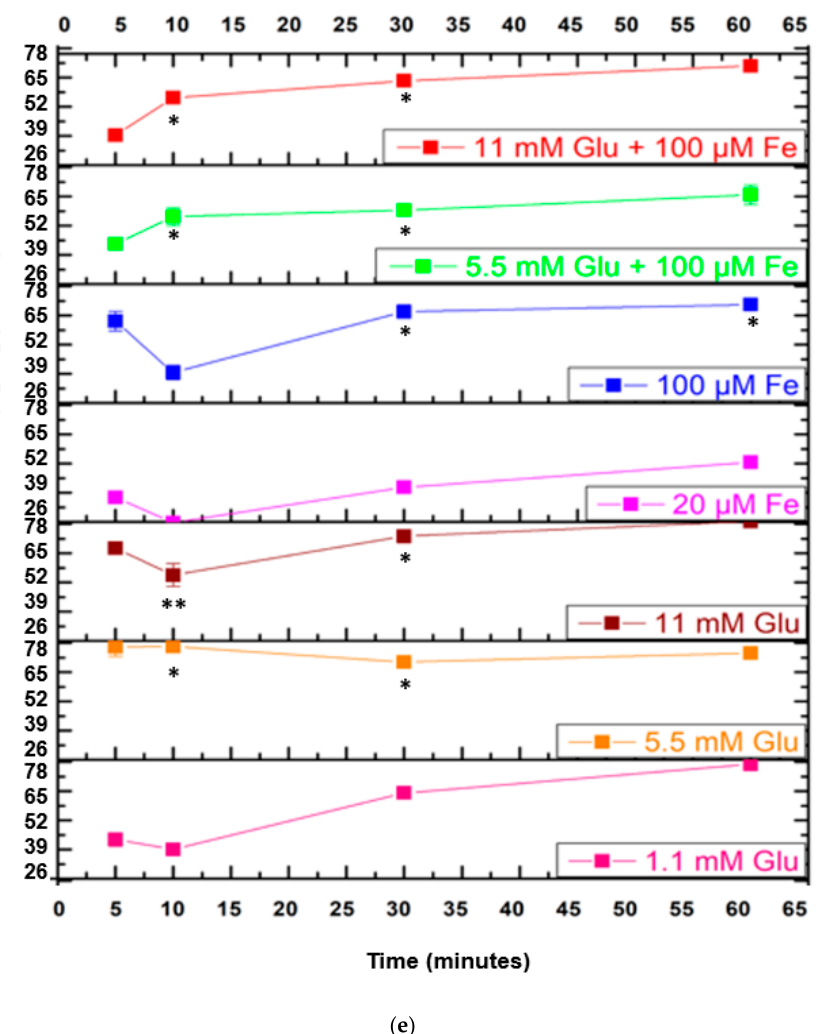
Figure 7. The effect of treatment with varying concentrations of iron, glucose, and combinations of iron and glucose with the addition of tolbutamide on MIN6 cells insulin secretion. ( a ) The effect of treatment with 5.5 mM and 11 mM of glucose with the addition of tolbutamide on MIN6 cells insulin secretion following 3 h and 24 h incubation. The data represent mean ± SEM, n = 3. ( b ) The effect of treatment with 20 µ M and 100 µ M iron with the addition of tolbutamide on MIN6 cells insulin secretion following 3 h and 24 h incubation. The data represent mean ± SEM, n = 3. ( c ) The effect of treatment with 5.5 mM and 11 mM of glucose and/or 20 µ M and 100 µ M iron and combinations of iron and glucose with the addition of tolbutamide on MIN6 cells insulin secretion following 3 h and 24 h incubation. The data represent mean ± SEM, n = 3. ( d ) The effect of treatment incubation with varying concentrations of iron, glucose, and combinations of iron and glucose with the addition of tolbutamide on MIN6 cells insulin secretion acutely (5, 10, 30, 60 min). The data represent mean ± SEM, n = 3. * p < 0.0036 (5.5 mM Glu (C1)—10 min), ** p < 0.037 (11 mM Glu (C2)—10 min), ** p < 0.005 (20 µ M Fe (C3)—10 min), * p < 0.026 (5.5 mM Glu + 20 µ M Fe (C6)—10 min), * p < 0.01 (11 mM Glu + 100 µ M Fe (C8)—10 min); * p < 0.013 (C3—60 min). ( e ) The effect of treatment with varying concentrations of iron, glucose, and combinations of iron and glucose with the addition of tolbutamide on MIN6 cells insulin secretion following 24 h (5, 10, 30, 60 min). The data represent mean ± SEM, n = 3. * p < 0.049 [11 mM Glu (C2)—24 h (5 min)], * p < 0.022 [20 µ M Fe (C3)—24 h (5